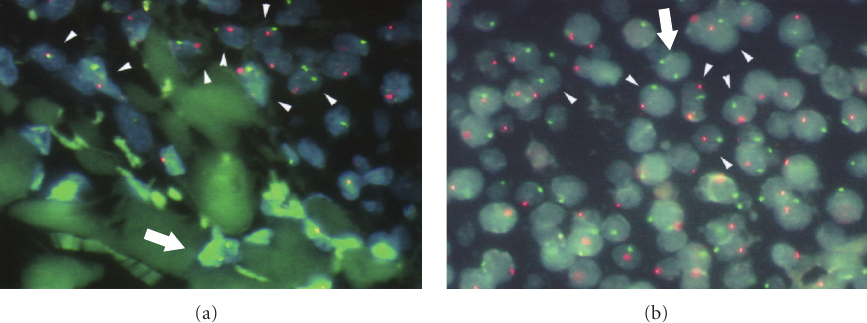
Figure 1: Fluorescence in situ hybridization analysis: maternal XX karyotype cells (arrowed lines/two green dots) among XY cells (arrowheads/red and green dots) in the skin (a) and lymph node (b).